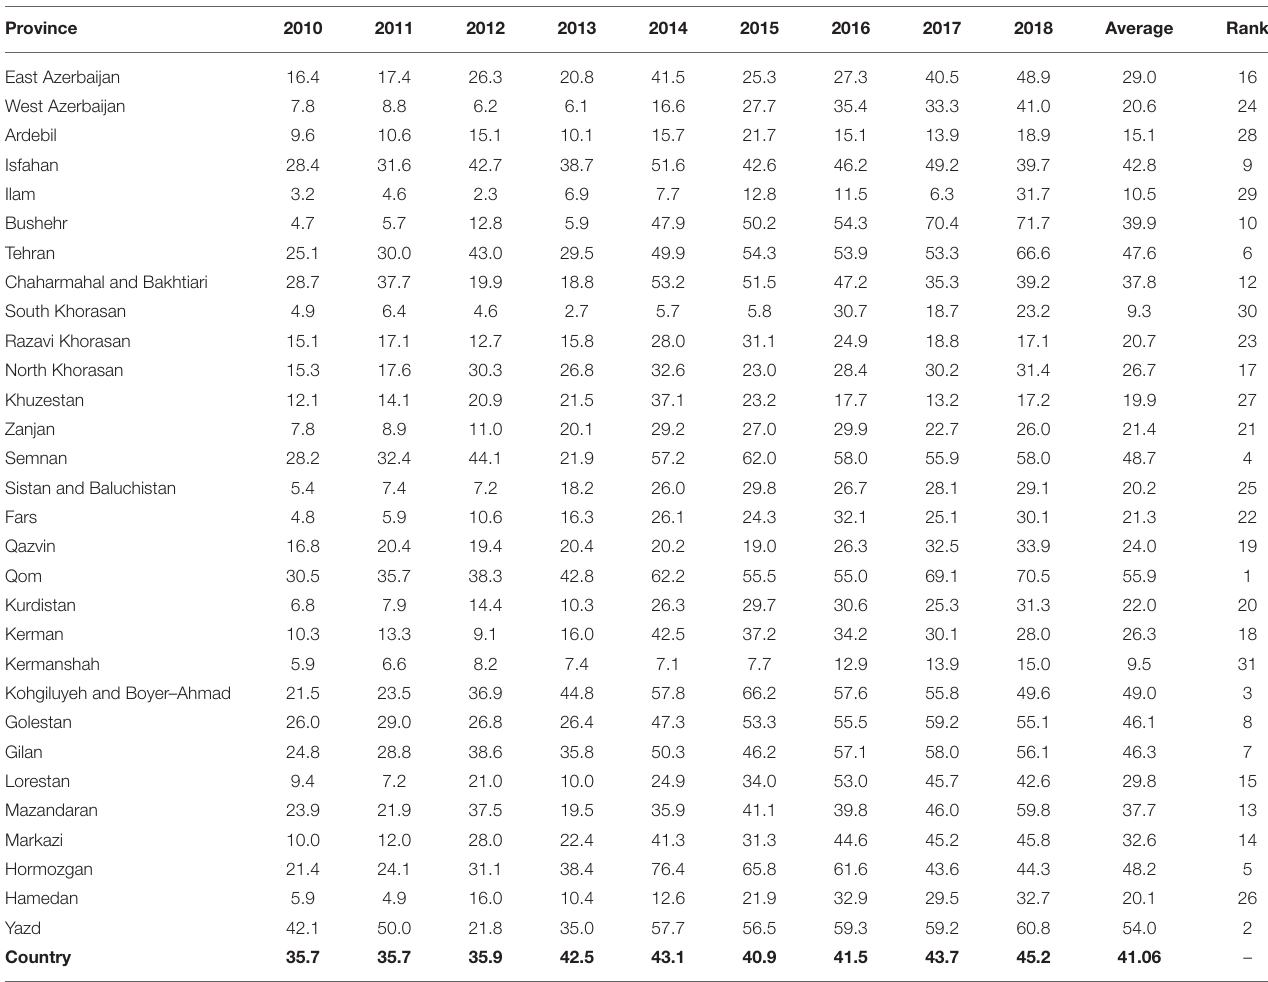
TABLE 4 | The percent of food insecure households in urban areas of provinces in Iran.